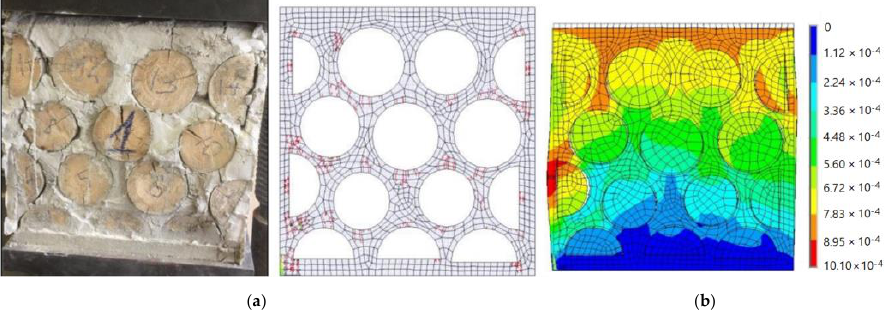
Figure 11. The behaviour of the cordwood specimen C-1, obtained by the FEM model: ( a ) develop- ment of the crack in the course of loading; ( b ) total displacements of cordwood specimen under the action of maximum compression force.